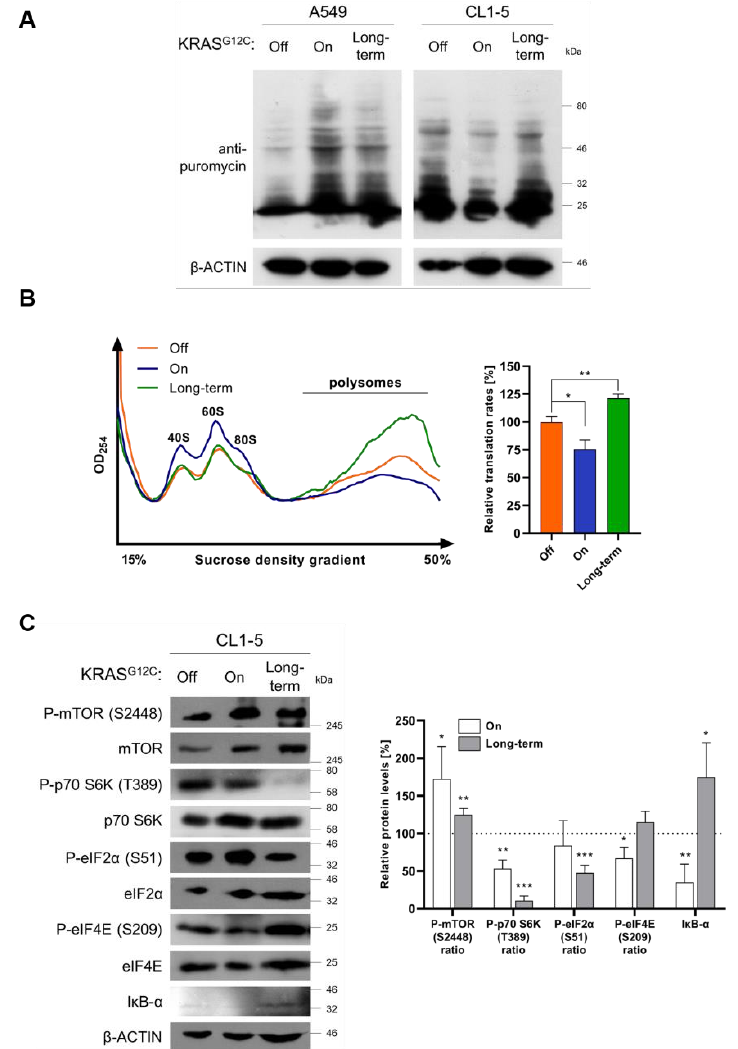
Figure 4. KRAS G12C can either enhance or impair cap-dependent translation initiation. ( A ) Non- radioactive measurement of translation rates using puromycin staining of nascent peptides before addition of doxycycline (Off) and after short-term (72 h) and long-term (>1 month) induction of KRAS G12C in A549 and CL1-5 cells. ( B ) Polysome profile analysis before addition of doxycycline (Off) and after short-term (72 h) and long-term (>1 month) induction of KRAS G12C in CL1-5 cells analyzed on 15 – 50% sucrose density gradients upon treatment with cycloheximide. The peaks corresponding to ribosomal subunits (40S, 60S and 80S) and the polysomes tail are indicated. Relative polysome levels (%) were calculated by measuring the AUC on ImageJ (Fiji) and compared to the means AUC of the control triplicates. ( C ) Immunoblot analysis of key proteins involved in translation regulation in CL1-5 cells before addition of doxycycline (Off) and after short-term (72 h) and long-term (>1 month) induction of KRAS G12C in CL1-5 cells. The protein levels were normalized against β -actin levels in each separate set of experiments. Band intensities are shown as a percentage (%) of relative protein levels as compared to the means values of the control triplicates. Phosphorylation levels are shown as a ratio of phosphorylated to total relative protein levels, where indicated. Data are compared by using unpaired Student ’ s t -test and are presented as means ± SD of biological triplicates. P -values are indicated with * p < 0.05; ** p < 0.01; *** p < 0.001.